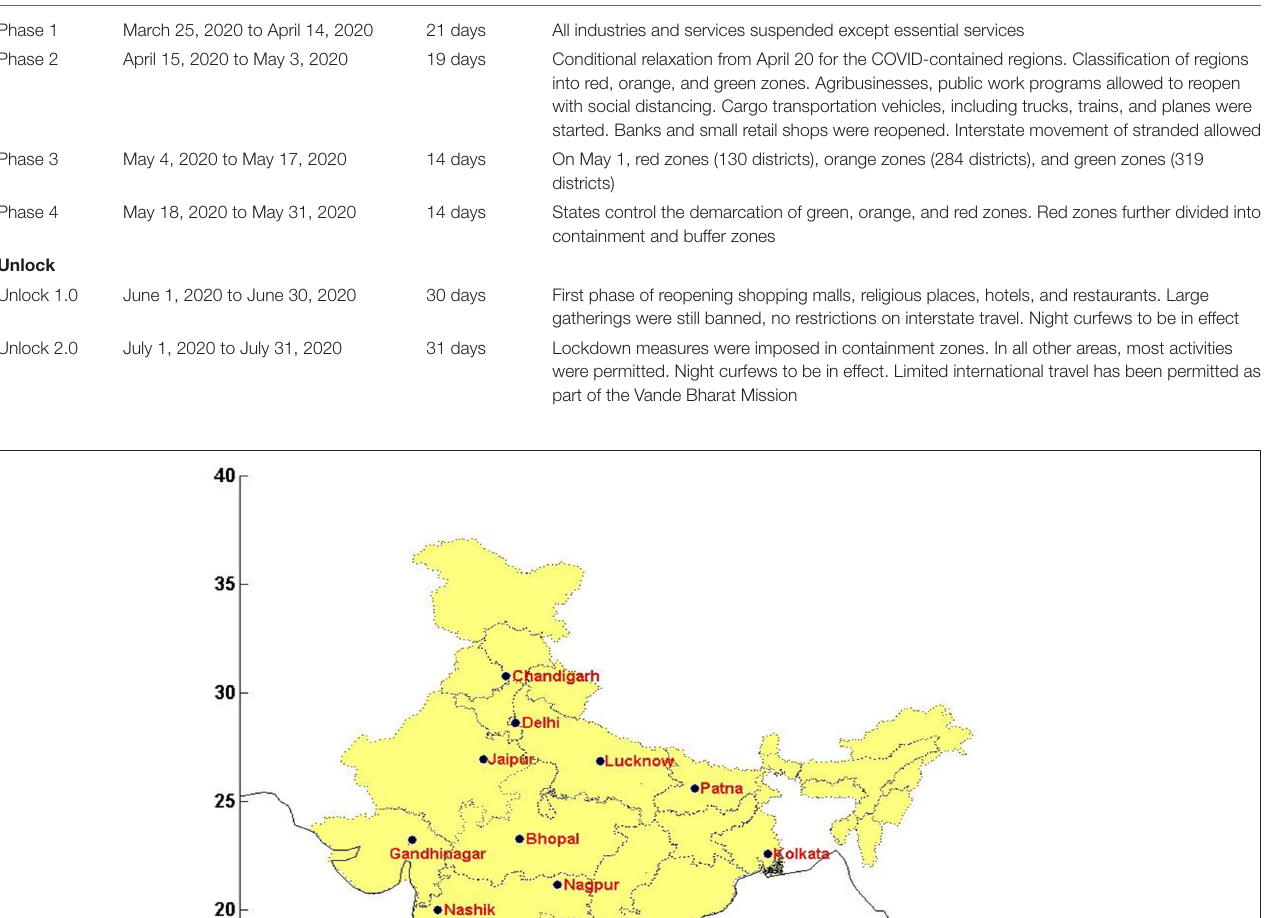
on ambient AQI. The hourly wind vector at 2 m (above the ground) and mixing-layer height data over all studied 16 cities (during March to June, 2017–2020) have been obtained from ERA5 global reanalysis products